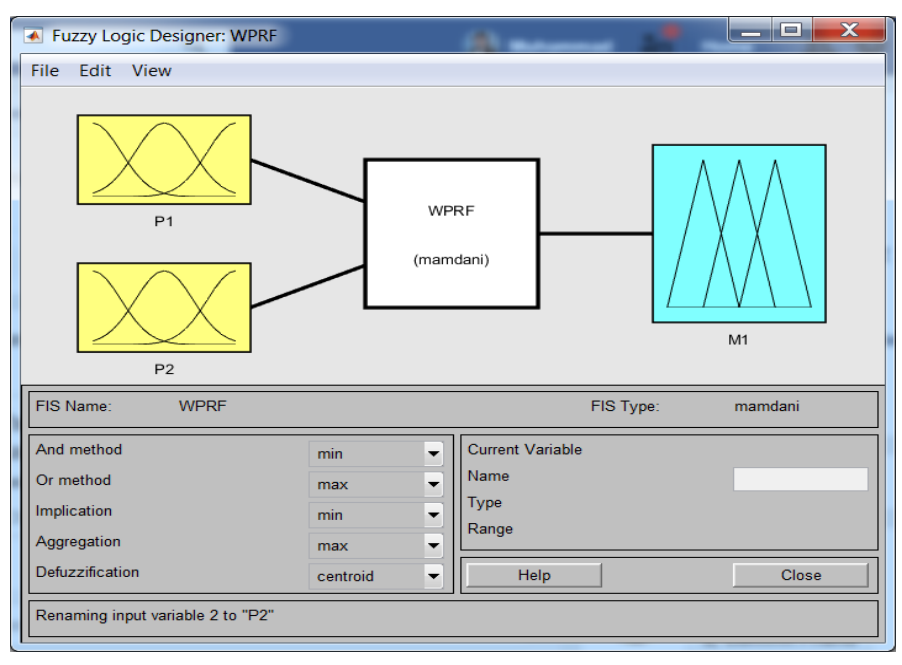
Figure 7. Mamdani fuzzy inference system for WPR F fuzzy logic.